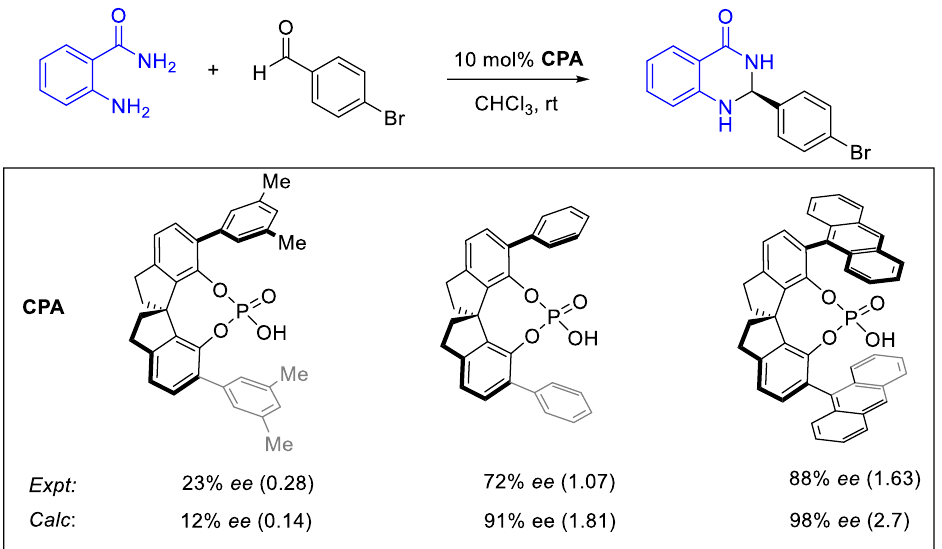
Figure 25. SPINOL-CPA catalyzed asymmetric synthesis of dihydroquinazolinones [187]. All values are obtained from the work of Wheeler and co-workers. % ee are calculated from ΔΔ G ‡ 298.15K, 1atm at PCM(CHCl 3 )/B97-D3/def2-TZVP//PCM(CHCl 3 )/B97-D/def2-TZVP from the cited reference. Numbers in parentheses are the corresponding ΔΔG ‡ at 298.15K in kcal/mol.